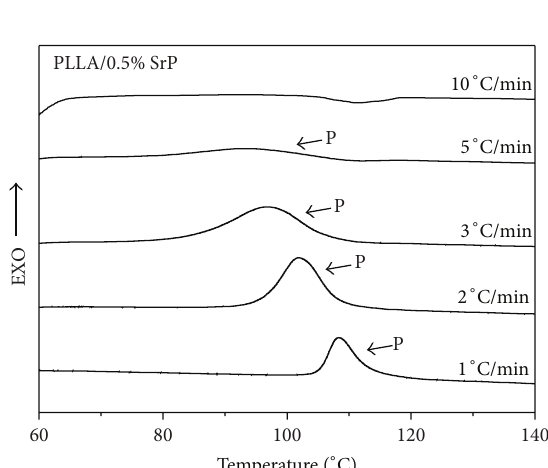
Figure 2: SEM of SrP.